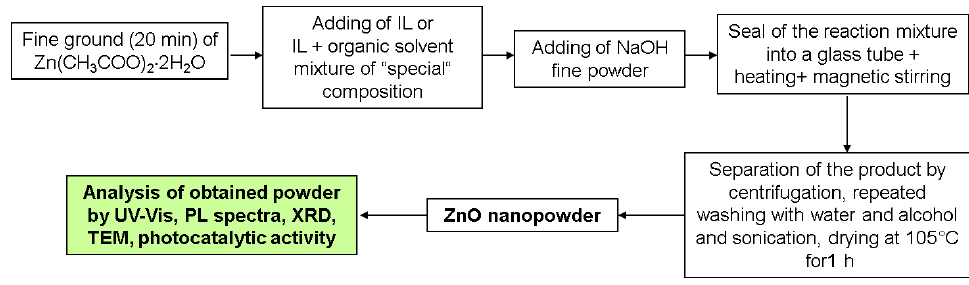
Figure 1. Scheme of the synthesis of ZnO